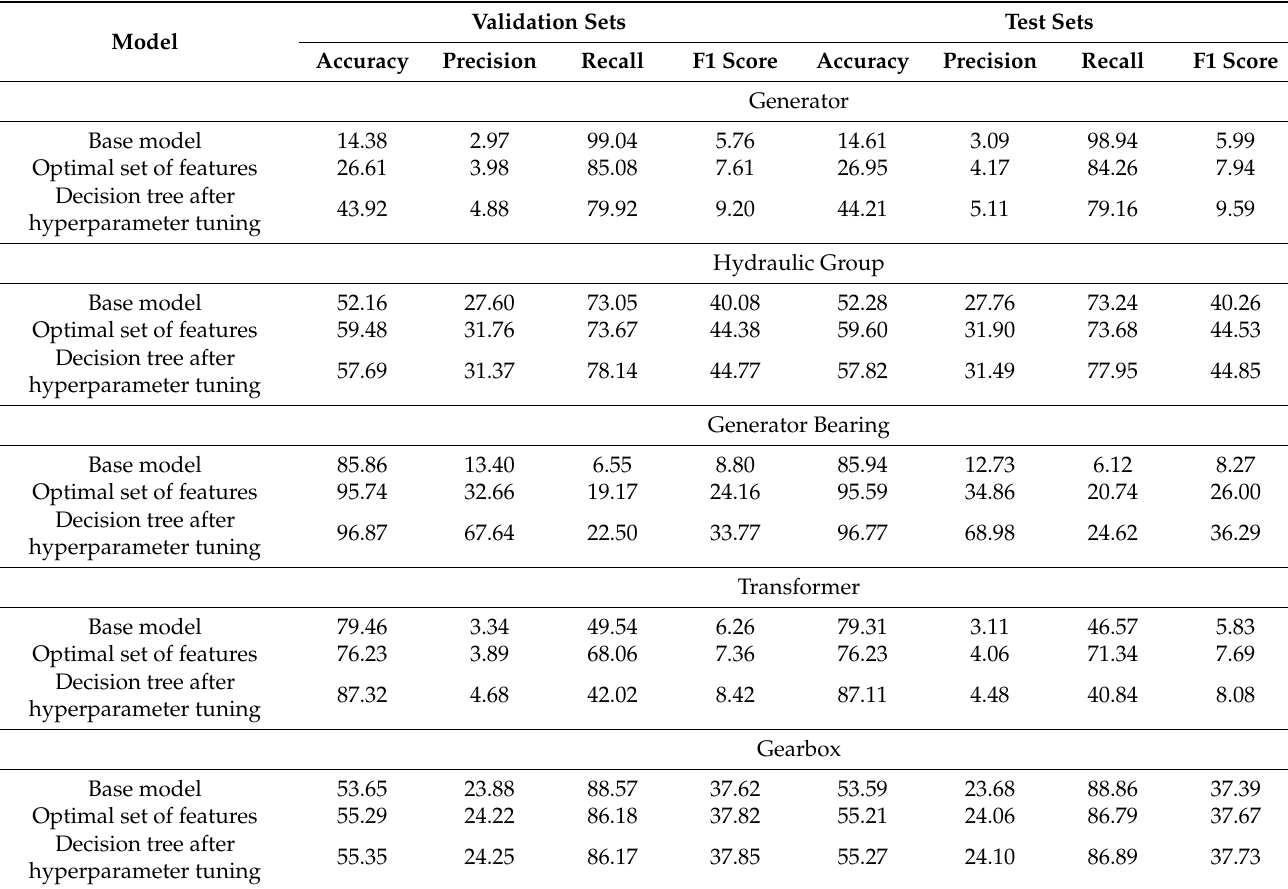
Table 5. Model training summary. Values are presented in